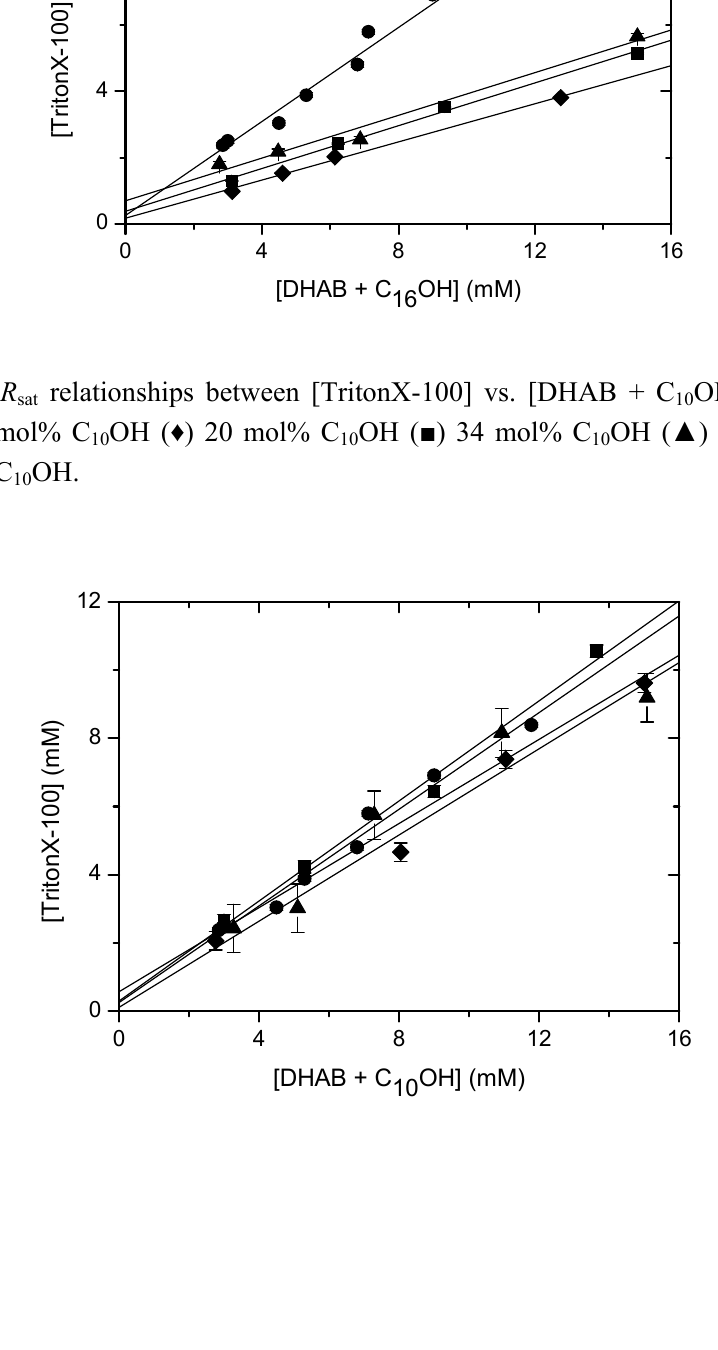
Figure 3A. R relationships between [TritonX-100] vs. [DHAB + C sat